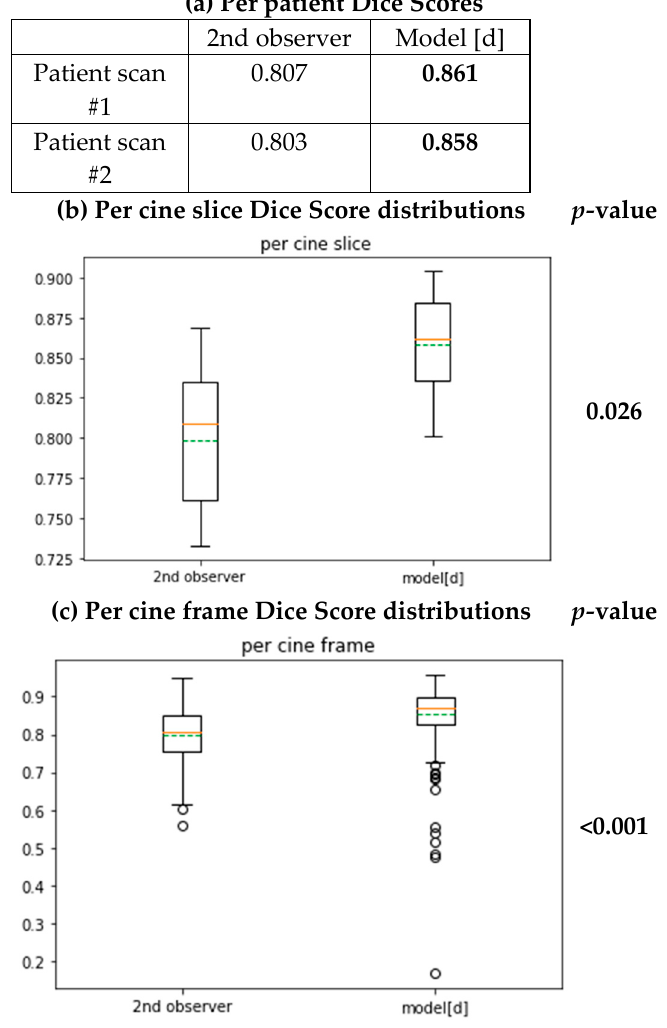
Figure 7. Boxplots for the Dice distribution of the 2nd observer and model [d] and its statistical tests for difference. In the boxplot, the orange line indicates the median value, the green line indicates the mean value and the dots around indicate the outliers. Outliers here are defined as data points above Q3 + 1.5 × IQR or below Q1 − 1.5 × IQR of the distribution. (Q1: first quartile, Q3: third quartile, IQR: interquartile range (Q3–Q1).)